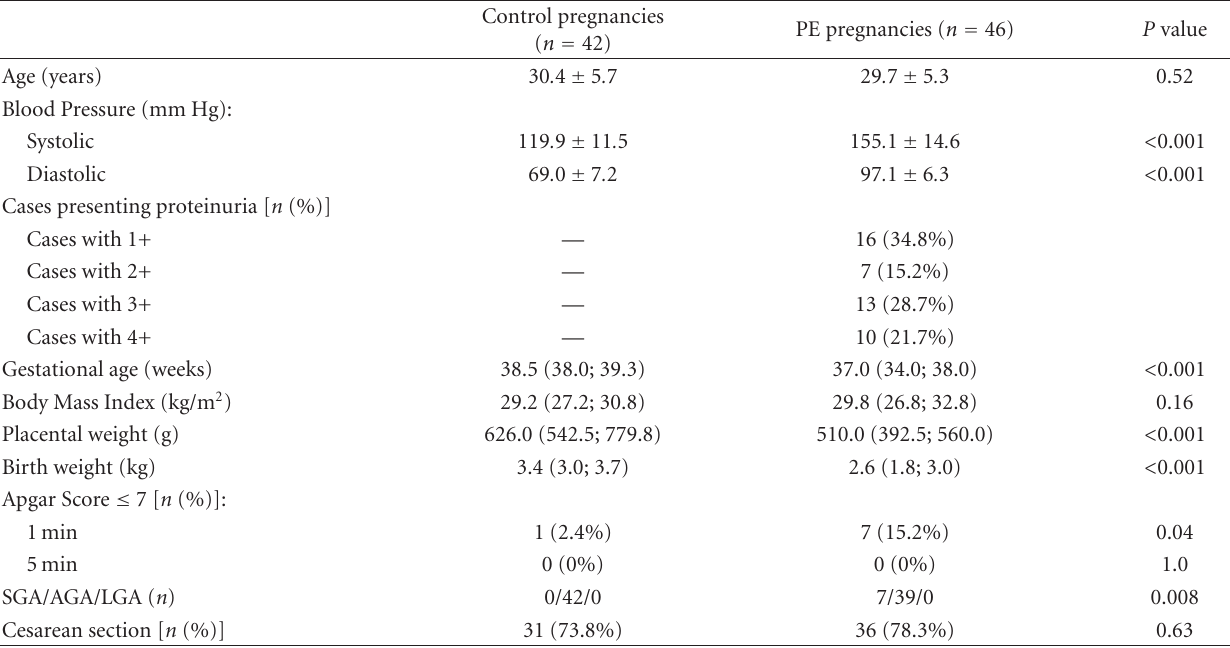
Table 1: Clinical data of normal and PE cases at